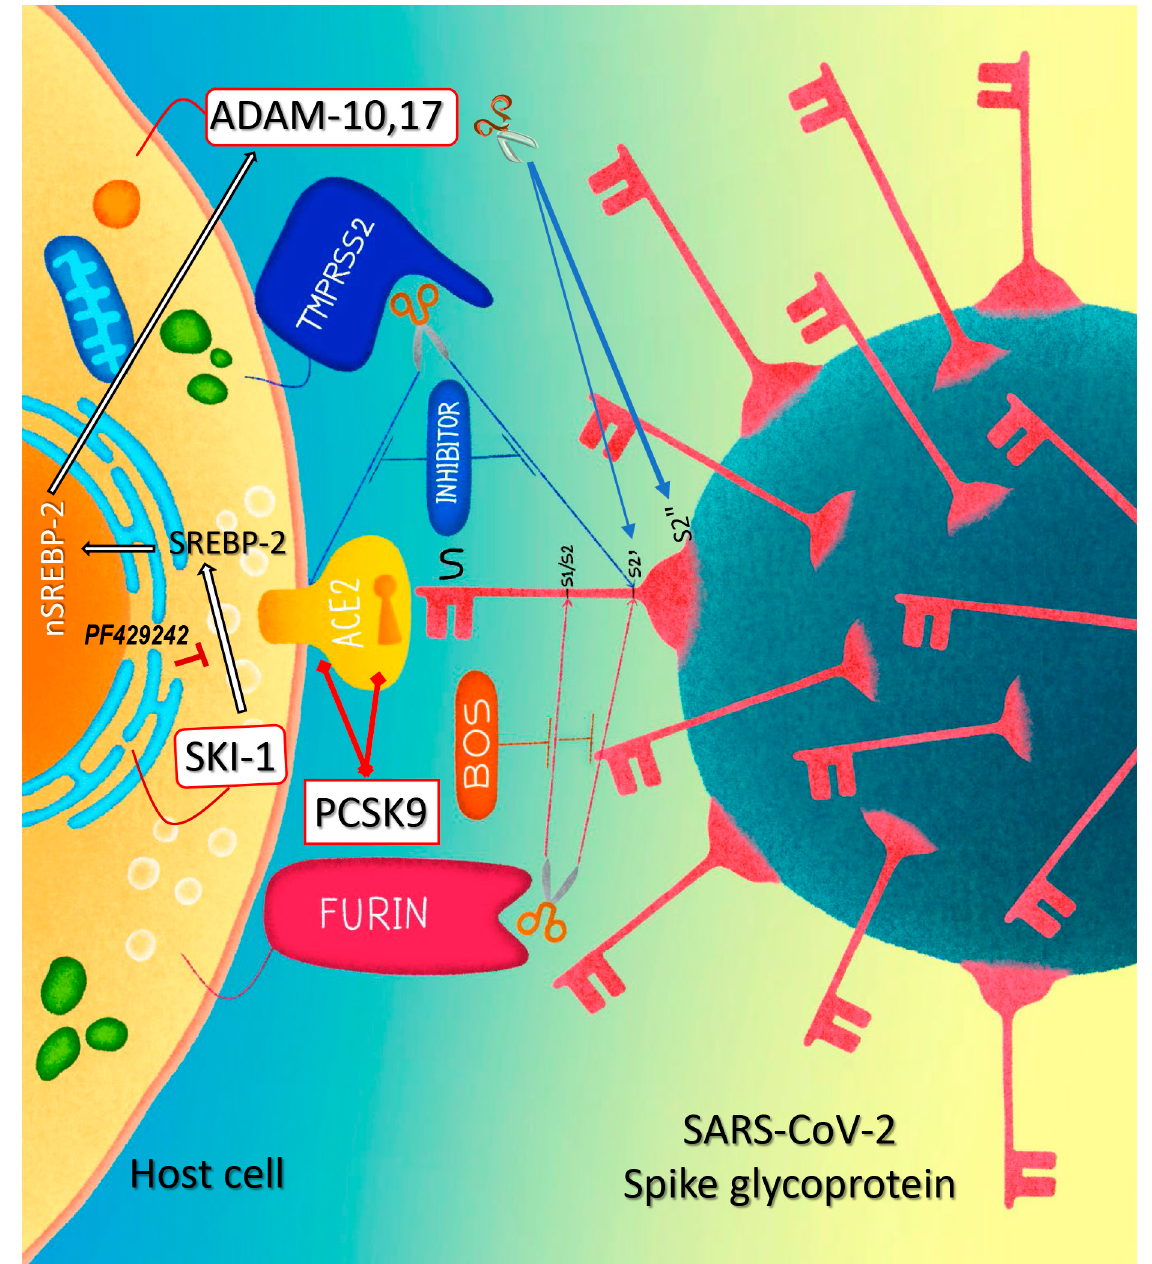
Figure 9. Graphical representation of a working model of SKI-1 and PCSK9 effects on cell-to-cell fusion. At low level of sterols in the cell, SREBP-2 moves from the ER to Golgi where it is cleaved by SKI-1 and then activated by S2P [29], the N-terminal domain of SREBP-2 (nSREBP-2) is then translocated to the nucleus and triggers the transcription of genes that are involved in cholesterol synthesis [102]. In turn, cholesterol increases the activity of metalloproteinases at cell surface, notably ADAM10 and ADAM17 [24]. The activated metalloproteinases enhance the cleavage of the S-glycoprotein at S2 ′ and increase cell-to-cell fusion [21]; they also shed the protein by cleaving it at S2” close to the TMD (this work). The cleavage at S2 ′ site can also be achieved by furin and TMPRSS2, and the latter sheds ACE2 as previously shown [9]. The combination of SKI-1 and/or metalloproteinase inhibitors with a furin-like inhibitor can be a potent tool to control cell-to-cell fusion and viral entry. Extracellular PCSK9 enhances the degradation of ACE2 by a mechanism requiring only the prodomain/catalytic subunit of mature PCSK9 that likely bind ACE2, thereby reducing cell surface levels of ACE2, cell-to-cell fusion, and possibly SARS-CoV-2 infection. Author Contributions: R.E. and U.A. designed the project, performed the experiments, and partic- ipated in the writing of the manuscript together with N.G.S. A.E. generated all the mutants and